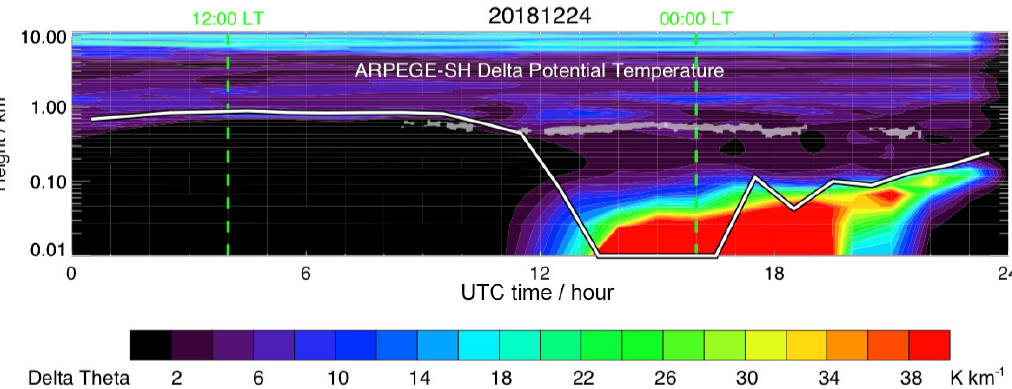
Figure 7. Time–height cross section of ∂θ/∂z (Kkm − 1 ) calculated from ARPEGE-SH temperature on 24 December 2018 (UTC time). Superimposed are the SLW cloud altitude (grey area) deduced from the lidar observations (see Fig. 1) and the top of the planetary boundary layer calculated by the ARPEGE-SH model (black–white thick line). Two vertical green dashed lines indicate 12:00 and 00:00LT.